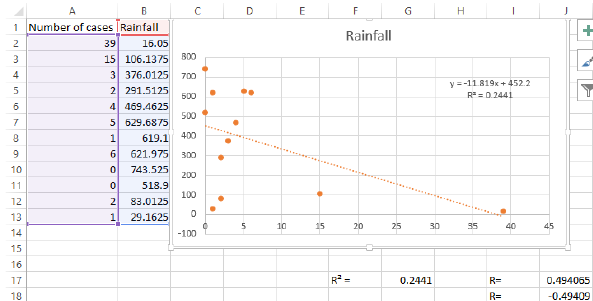
Figure 9. Graph showing the correlation between rainfall and Lassa fever cases